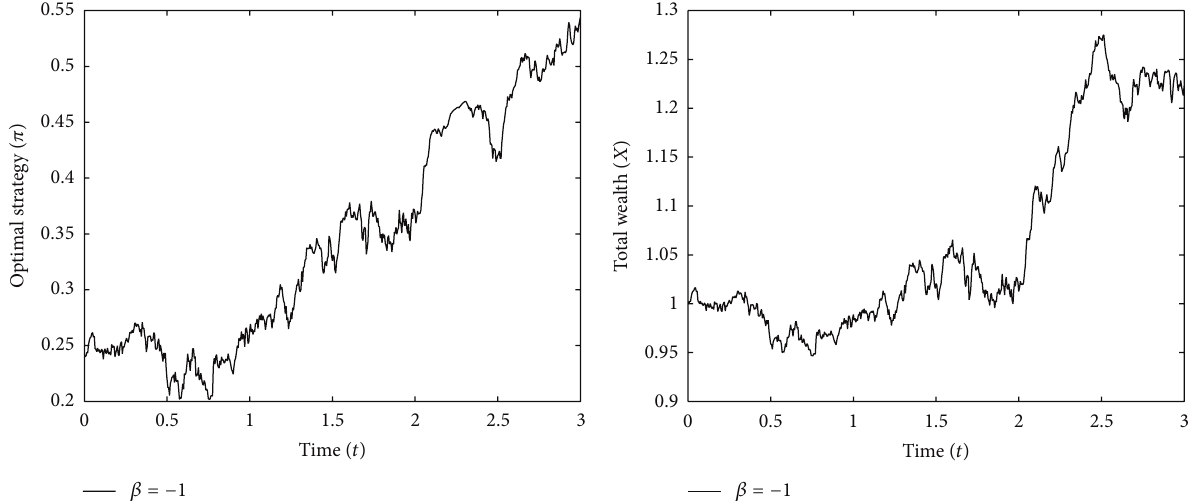
Figure 8: The evolutions of optimal strategy and total wealth over time ( 𝛽 = −1 ).